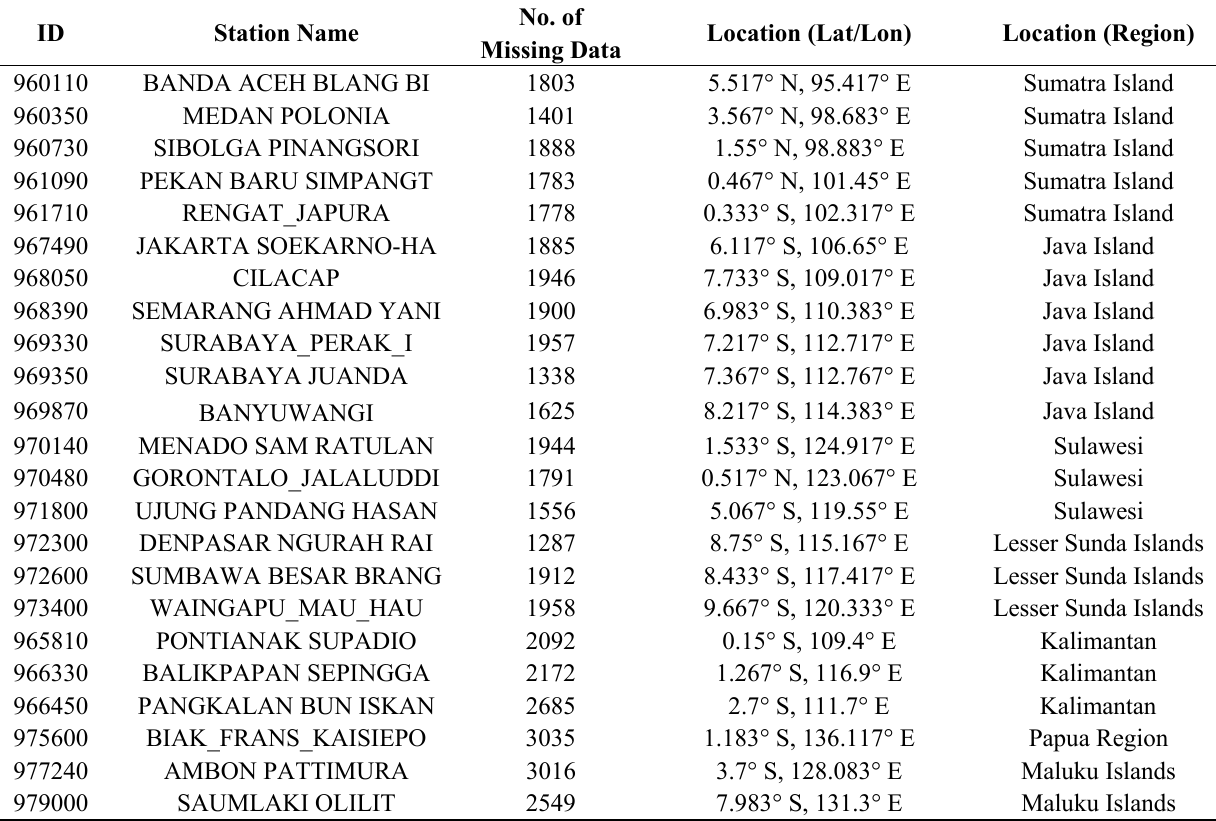
Table 1. List of the 23 surface weather stations in Indonesia obtained from the GSOD, NCDC, and NOAA. See Figure 1a for the